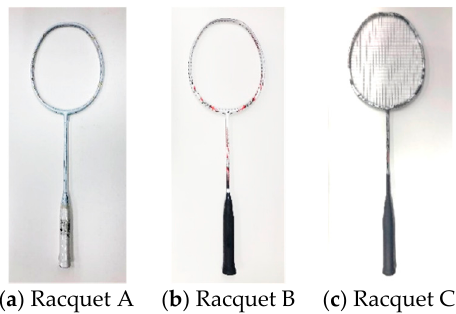
Figure 8. Three badminton racquets made by different companies,